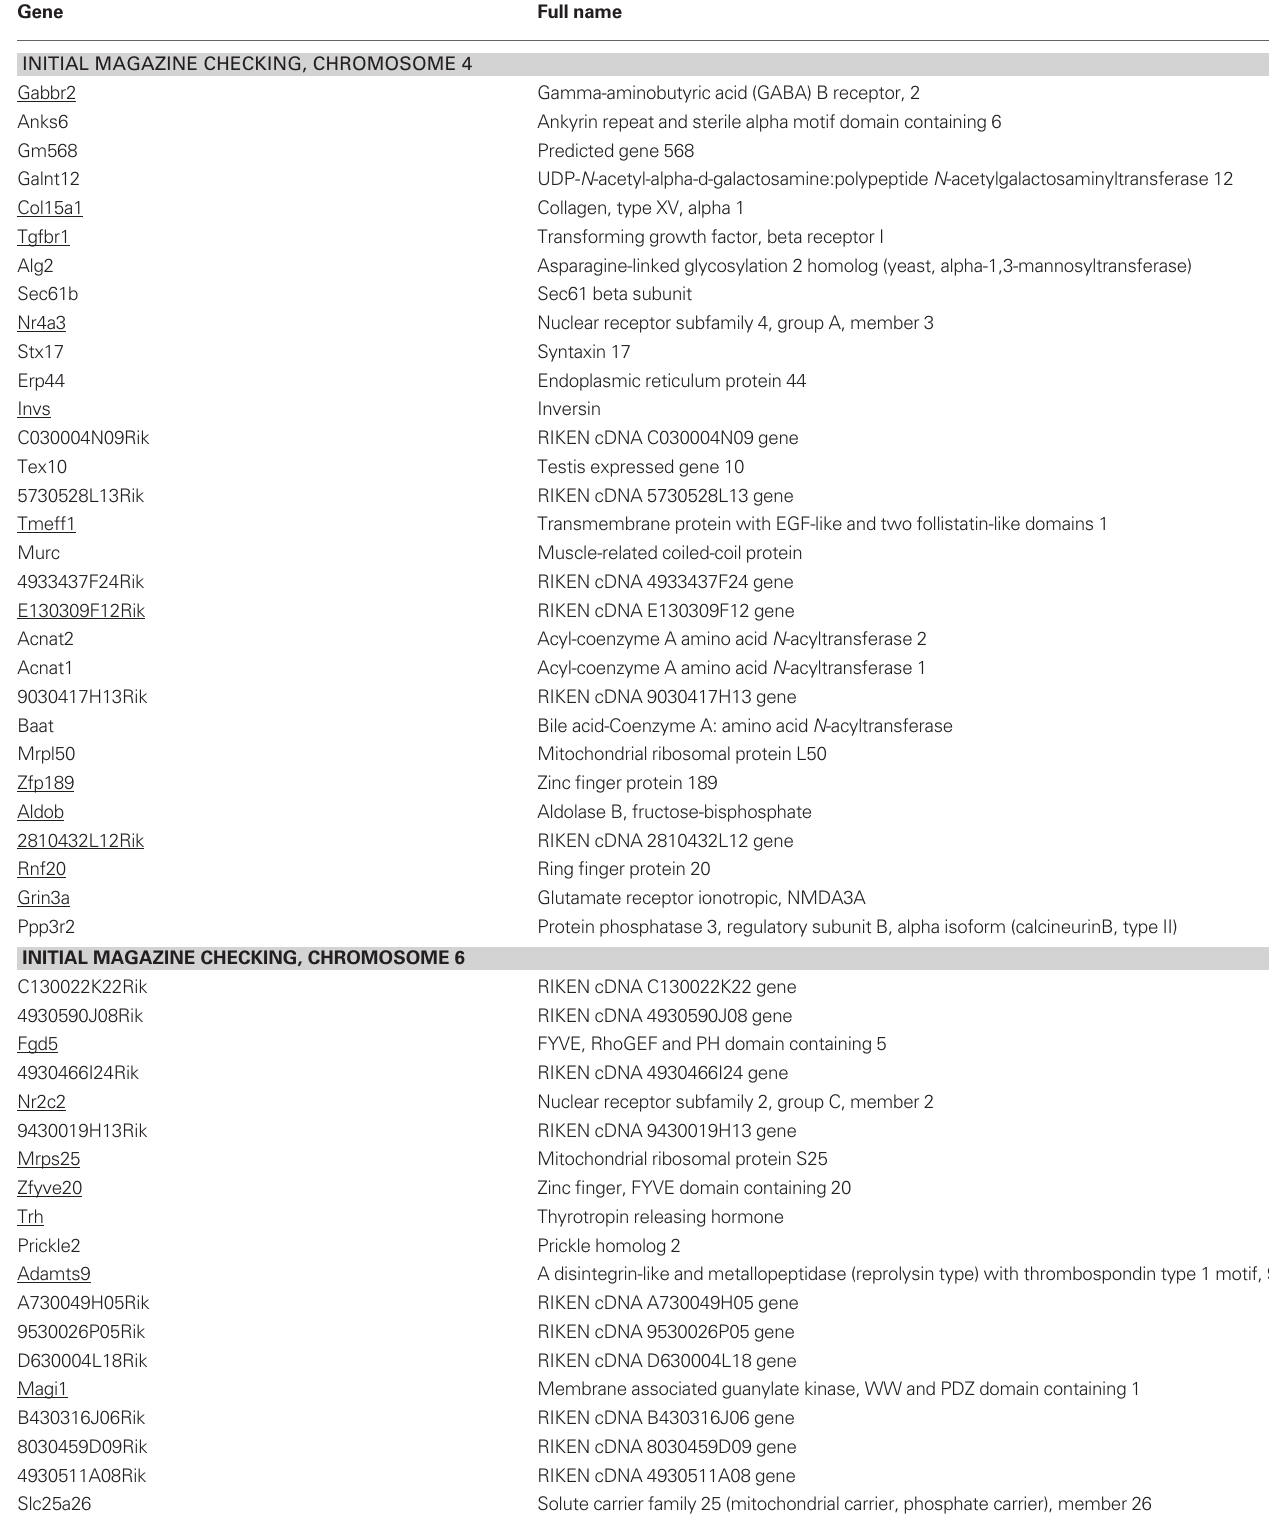
Table 2 | List of genes under suggestive LrS peaks. Genes are known to be expressed in the CNS according to Mouse Genome Informatix gene expression database (www.informatics.jax.org) are